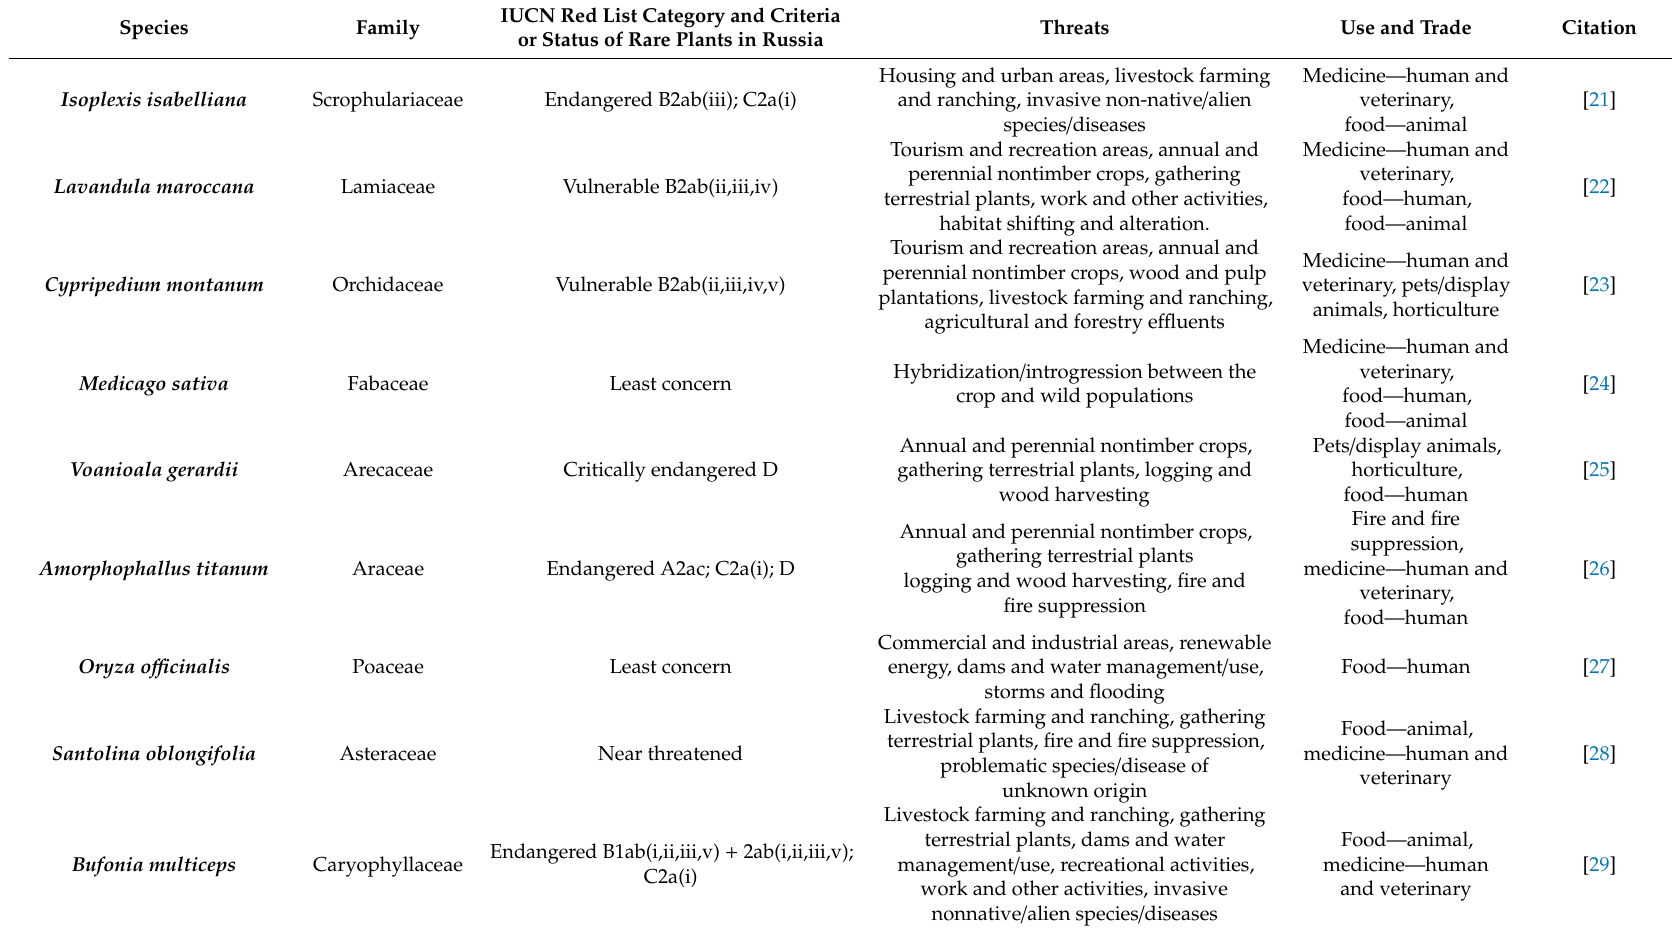
Table 1. Some of the rare plants in human